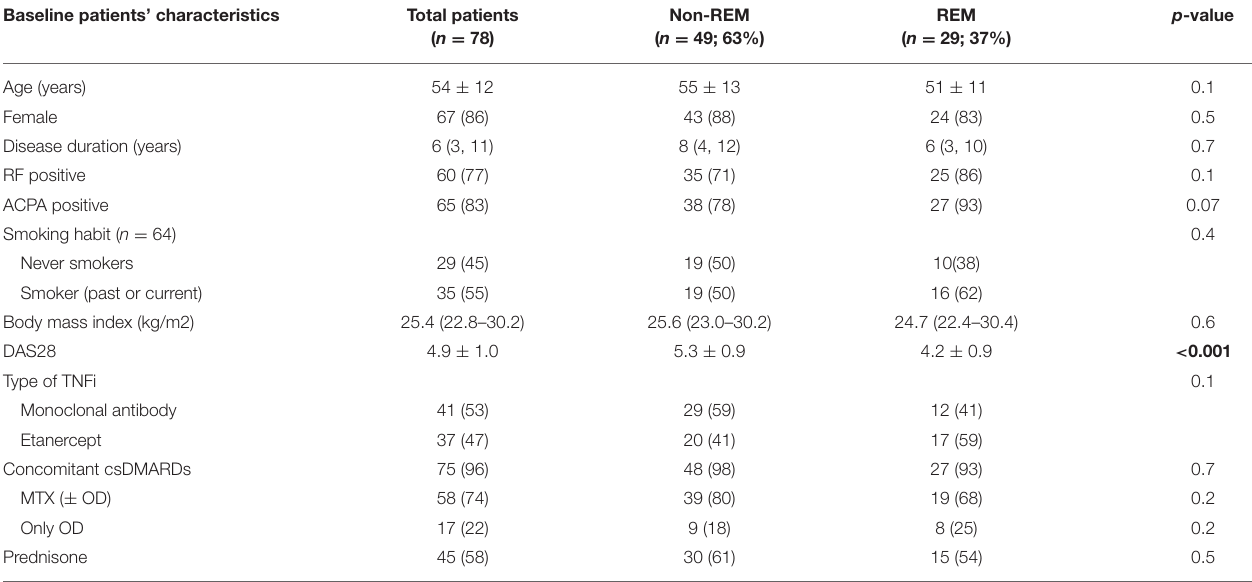
TABLE 1 | Baseline characteristics of patients included in the study. Baseline patients’ characteristics